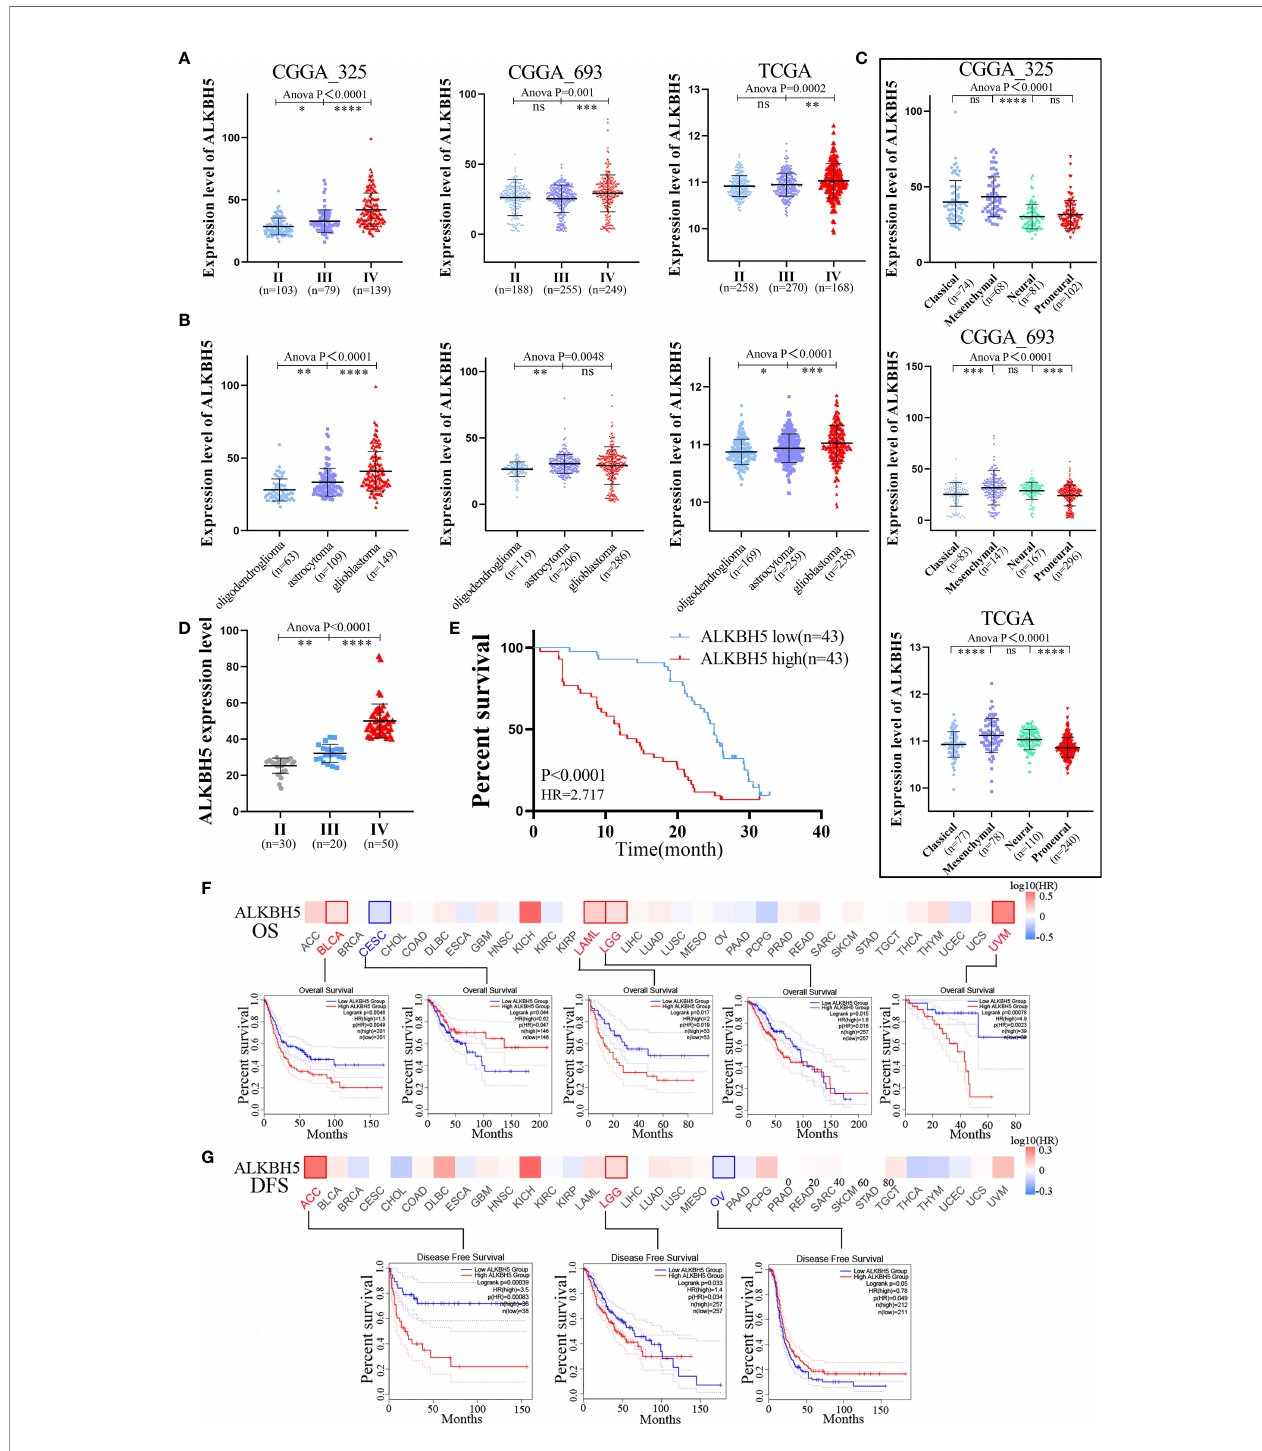
FIGURE 2 | Clinical and molecular characteristics of ALKBH5 in pan-cancer, including gliomas. (A) The correlation between ALKBH5 expression and glioma WHO grade (II, II and IV) in CGGA_325, CGGA_693 and TCGA datasets; (B) The correlation between ALKBH5 expression and glioma three types (oligodendroglioma, astrocytoma and glioblastoma) in CGGA_325, CGGA_693 and TCGA datasets; (C) The relationship between ALKBH5 expression and glioma subtypes (classical, mesenchymal, neural, and proneural) in CGGA_325, CGGA_693 and TCGA datasets; (D) The correlation between ALKBH5 expression and grades in 100 glioma samples, including grade II (n=30), grade III(n=20) and grade IV (n=50) samples; (E) Overall survival (OS) of different ALKBH5 expression level in 100 glioma samples. The GEPIA2 tool was used to perform OS (F) and disease-free survival (DFS) (G) analyses of different tumors in TCGA by ALKBH5 expression. Red label indicated positively correlated, blue label indicated negatively correlated. * P <0.05, ** P <0.01, *** P <0.001, **** P